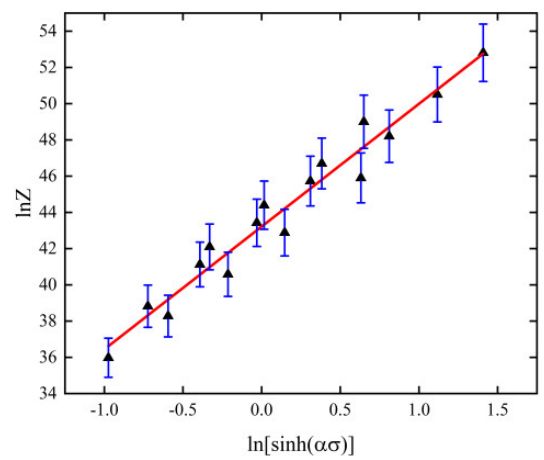
Figure 5.  − [ℎ()] relationship curve. Figure 5. lnZ − ln [ sinh ( ασ )] relationship